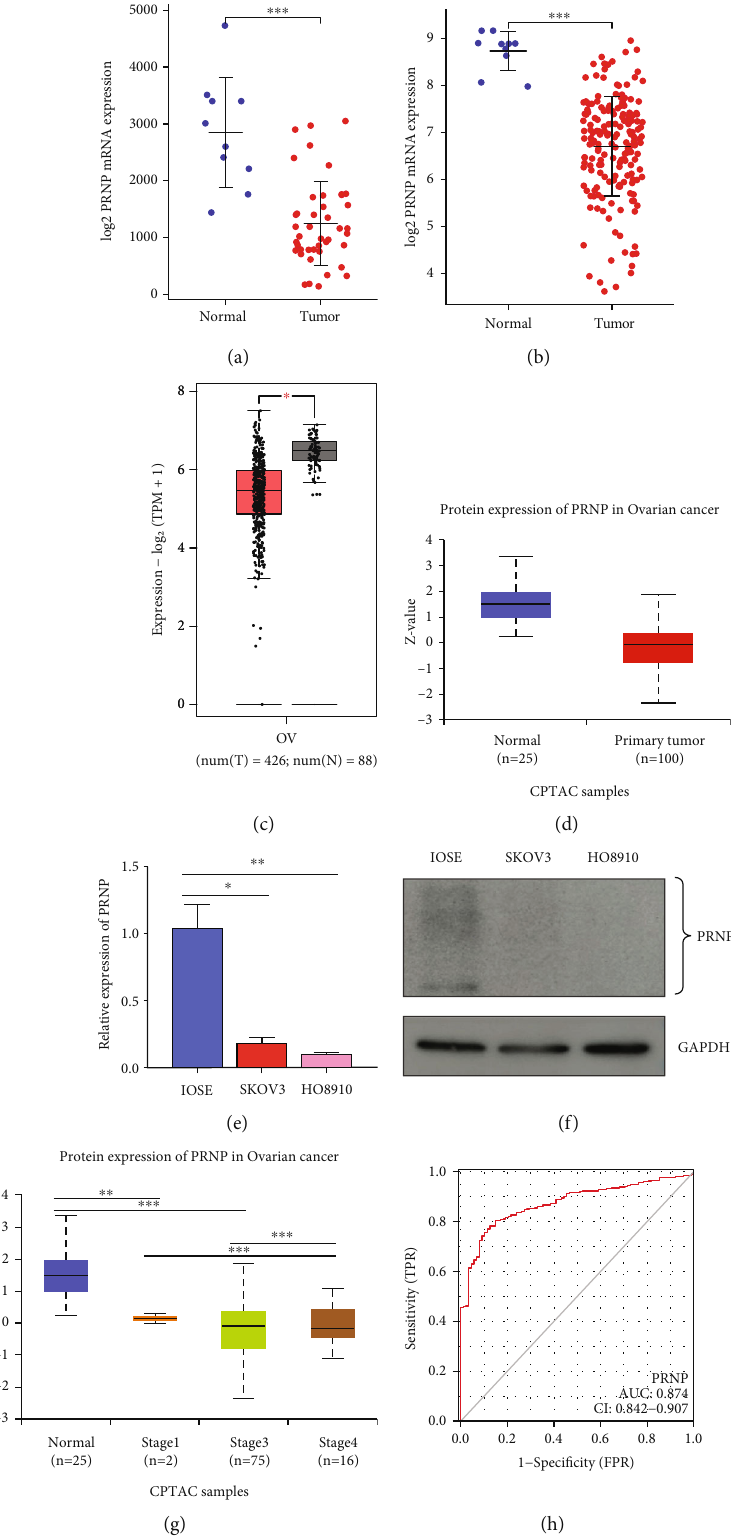
Figure 3: Analysis of PRNP expression in OC patients and cell lines. (a and b) The mRNA expression of PRNP in OC datasets GSE12470 and GSE26712. (c) The mRNA expression of PRNP in OC tissues returned from GEPIA 2.0 database. (d) The protein expression of PRNP in OC by using UALCAN database. (e and f) The mRNA and protein level of PRNP in OC cell lines. (g) The correlation of PRNP with cancer stages for patients with OC. (h) Evaluation of the diagnostic role of PRNP in OC. ∗ p < 0 : 05 , ∗∗ p < 0 : 01 , ∗∗∗ p < 0 : 00